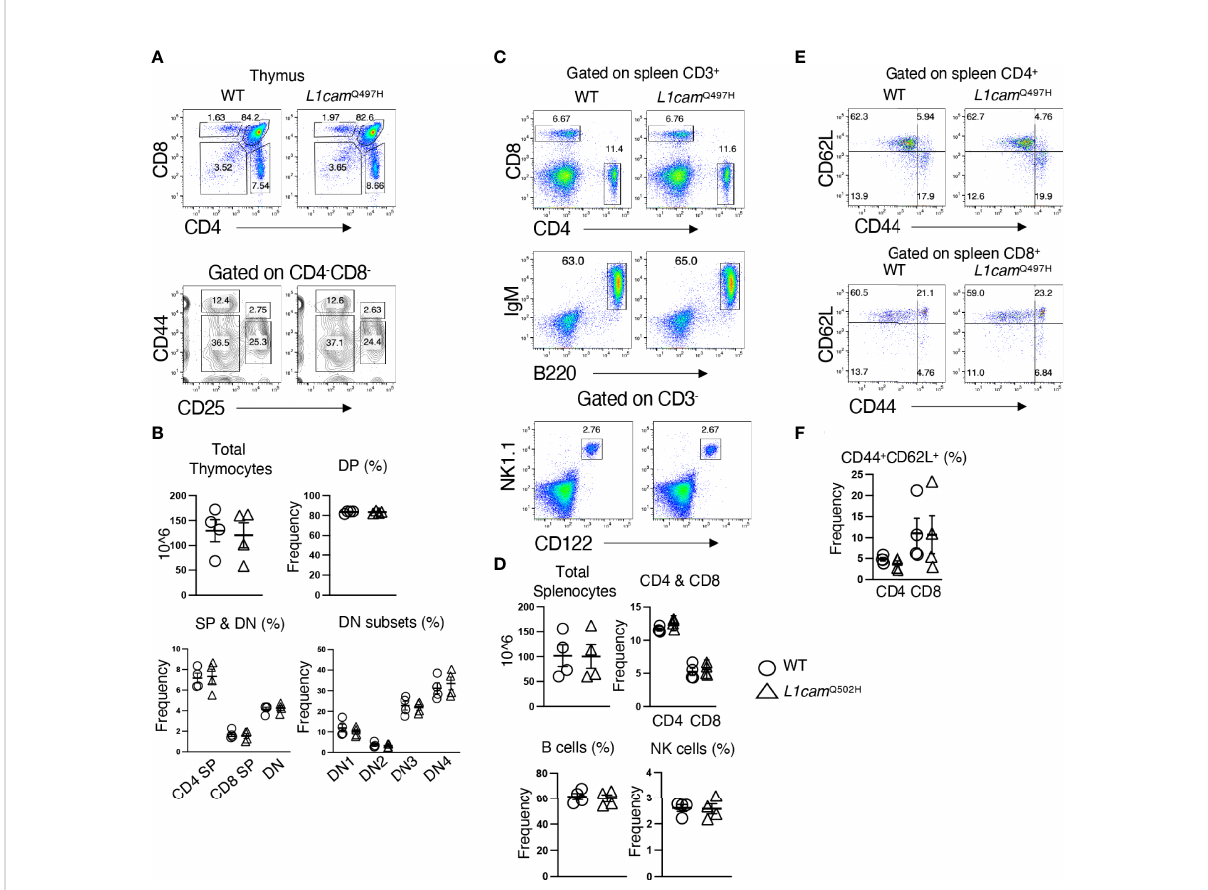
FIGURE 6 Phenotypic analysis of the L1CAM Q497H knockin mice. (A) Flow cytometric analysis of the frequencies of thymocytes from wildtype (WT) and hemizygous L1cam 497H mutant mice. (B) The total and subpopulations of thymic cellularity are shown in bar graphs. The following populations are graphed: DN, CD4 - CD8 - ; DP, CD4 + CD8 + ; CD4 + ; CD8 + ; DN1, CD4 - CD8 - CD25 - CD44 + ; DN2, CD4 - CD8 - CD25 + CD44 + ; DN3, CD4 - CD8 - CD44 - CD25 + ; DN4, CD4 - CD8 - CD44 - CD25 - . (C) Flow cytometry analysis of splenic CD4 + and CD8 + T cells, B (B220 + IgM + ) and NK (CD3 - CD122 + NK1.1 + ) cells in WT and L1cam Q497H mutant mice. (D) The total and subpopulations of splenic cellularity are shown in bar graphs. (E) Flow cytometry analysis of CD44 and CD62L staining of CD4 + and CD8 + T cells. (F) The frequency of CD44 + CD62L + in CD4 + and CD8 + T cells is shown in bar graphs. Data are representative of 2 independent experiments performed. No statistically signi fi cant differences were found in any of the indicated